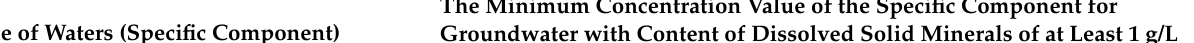
Table 1. Criteria for classification of medicinal